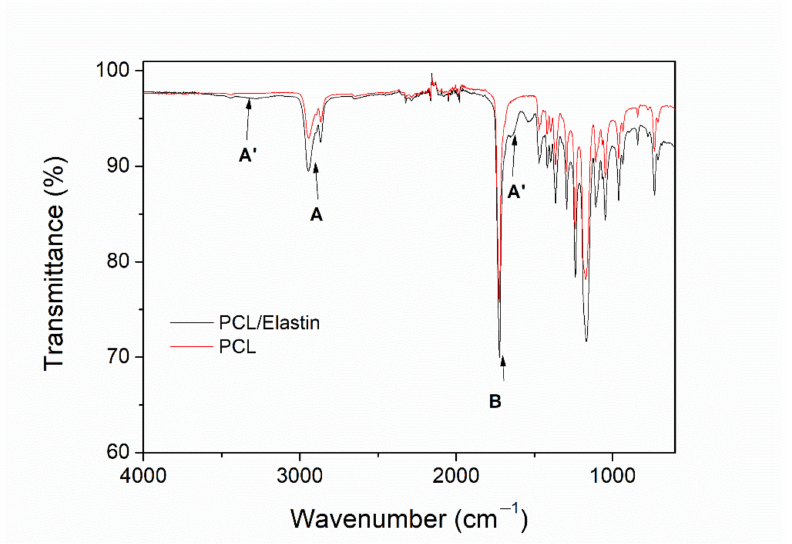
Figure 2. FTIR profile of PCL/elastin and PCL